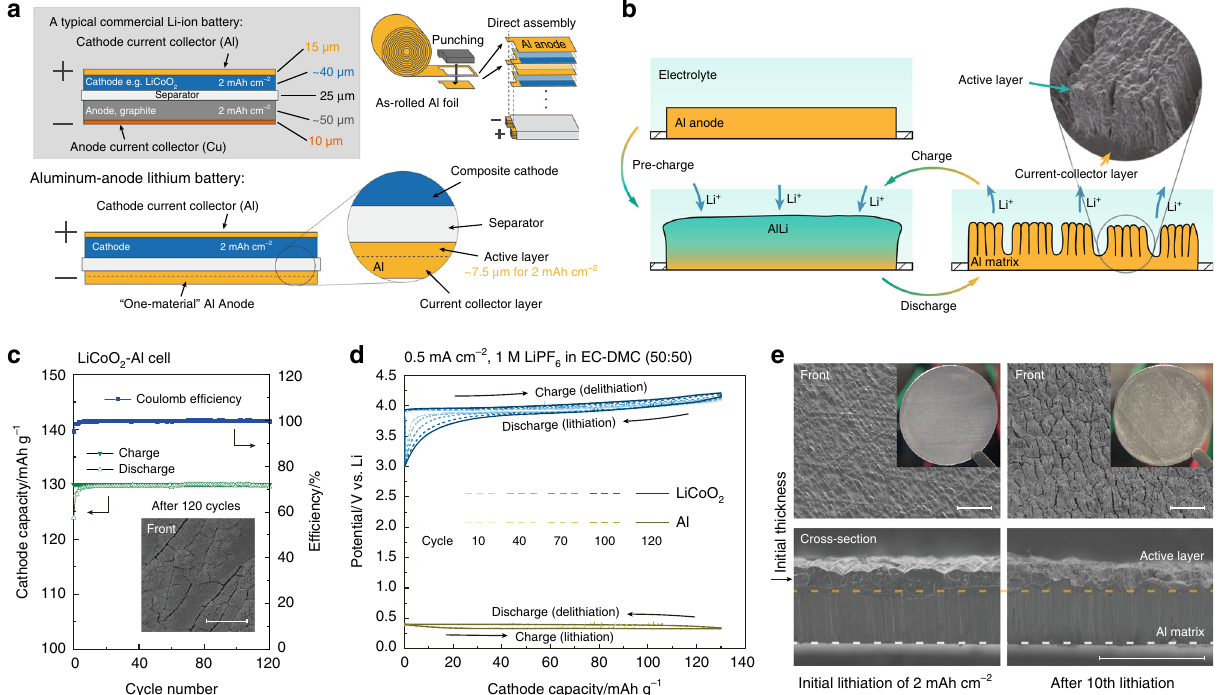
Fig. 4 Application and performance of an Al-anode lithium battery. a Structure of an Al-anode Li-ion battery compared with a conventional Li-ion battery. The Cu anode current collector is not needed when using the Al anode. The as-rolled Al anode can be assembled directly. b Electrode reaction of an Al anode. Al matrix is partly lithiated during pre-charge and the lithiated layer forms columnar-porous structure in discharge and works as the active materials in further cycles. c Cycle performance of a lithium battery consisting of an Al anode and a LiCoO 2 cathode. The inset SEM image shows the surface of the Al anode after 120 cycles. Electrode properties at initial cycles is shown in Supplementary Fig. 2e. d Potential pro fi les of cycle 10, 40, 70,100 and 120 in the cycle tests. No obvious degradation is observed on the Al anode. e Surfaces and cross-sections of Al anodes after initial lithiation of 2 mAh cm − 2 and after subsequent 10th lithiation. The active layer and current-collector layer are well-retained without consuming. Scale bars in SEM images are 100 μ